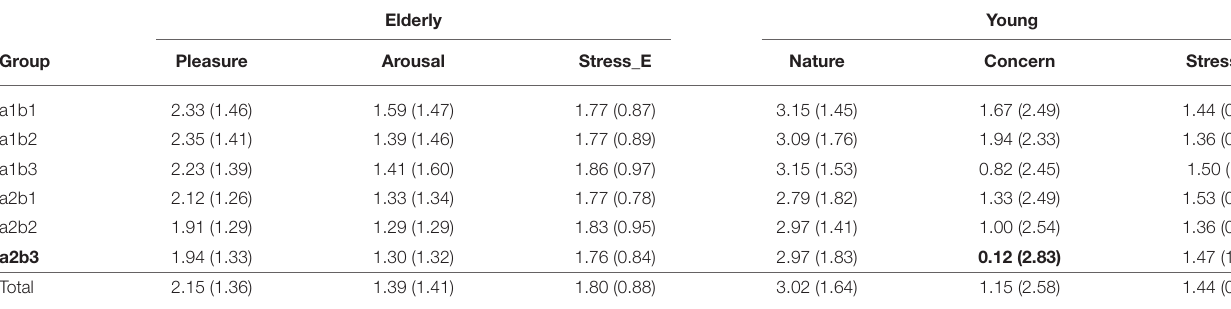
TABLE 2 | The PAS and NCS mean (SD) report in photo types.